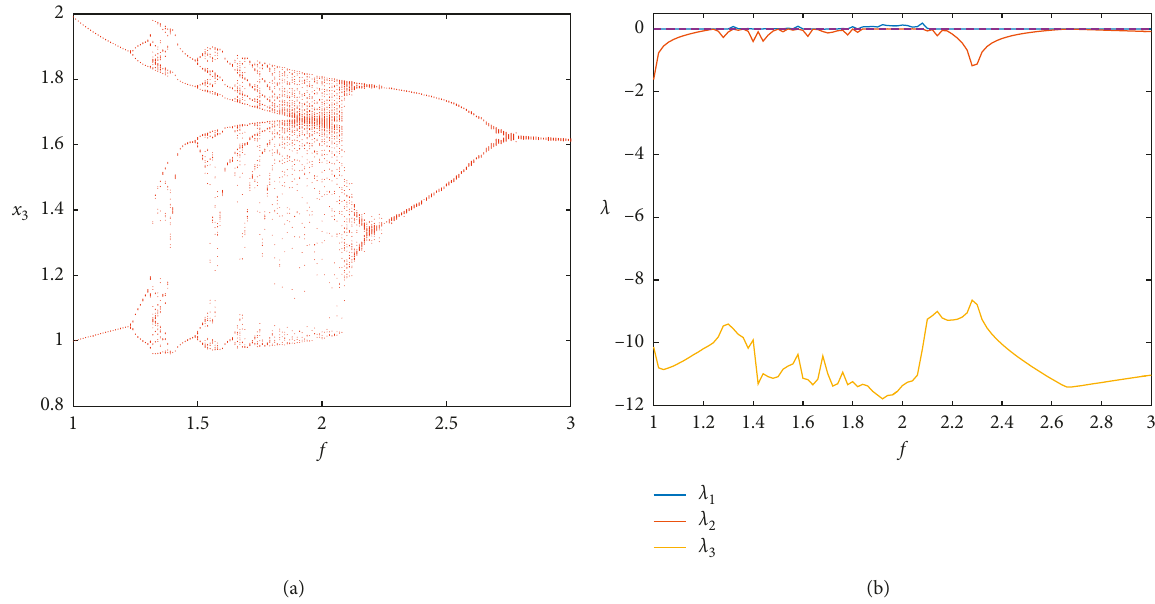
Figure 5: (a) Bifurcation diagram and (b) Lyapunov exponents of system (1) versus parameter f .